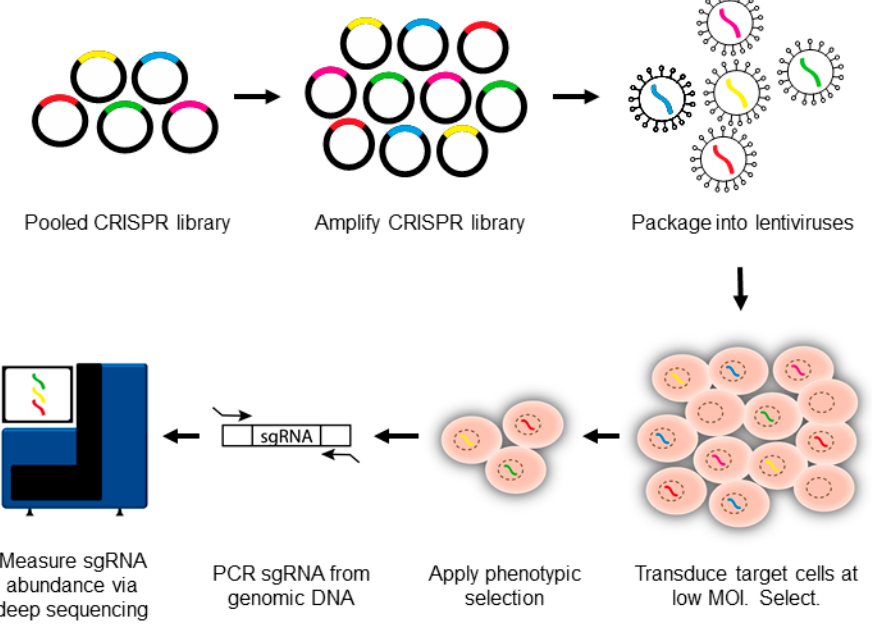
Figure 2. CRISPR–Cas9-pooled screen overview. Single-guide RNA (sgRNA) libraries are initially synthesized as lentiviral vectors and are then amplified and packaged into lentiviruses. The lentiviral vector encodes an sgRNA and a selectable marker, typically puromycin. Several libraries are now commercially available. Lentivirus pools are then used to transduce Cas9+ target cells at low multiplicity of infection (MOI). A low MOI is used to avoid coinfection by multiple lentiviruses. A positive or negative selection pressure is used to identify cells with a desired phenotype. The genomic DNA is extracted from input versus selected cell pools, and the integrated sgRNA sequences are PCR- amplified. The sgRNA abundance is then determined by next-generation DNA sequencing.